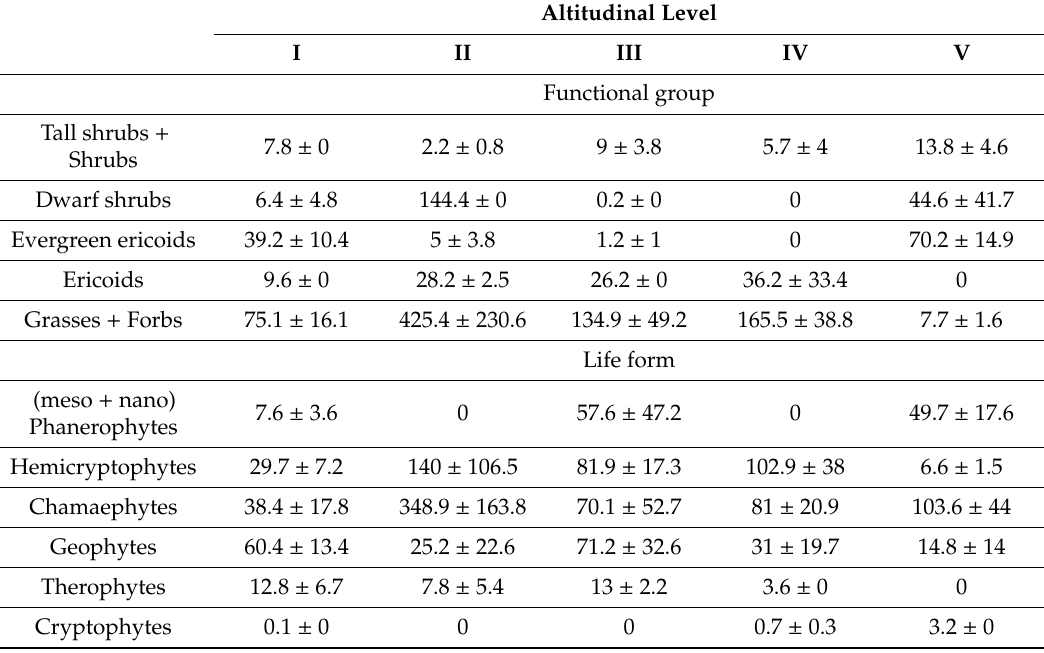
Table 2. Vascular plant aboveground biomass (g / m 2 ) of di ff erent functional groups and life